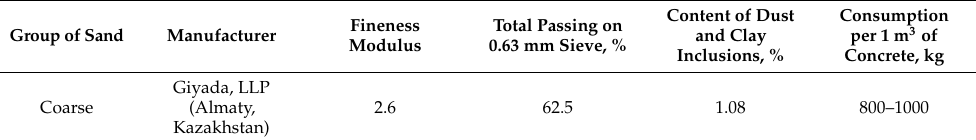
Table 3. Characteristics of sand